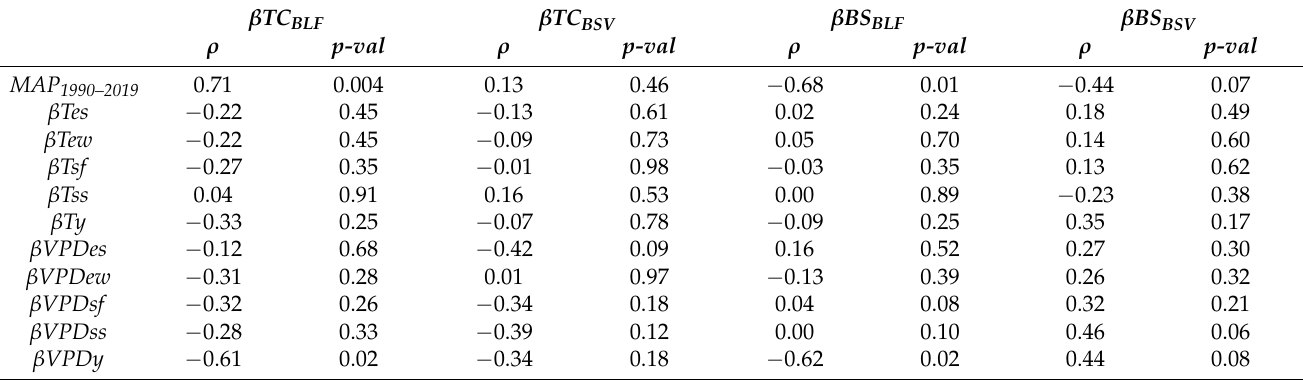
Table 4. Pearson correlation coefficients ( ρ ), and relative p-value between the Theil-Sen slope estimators of the percentage of tree cover and bare soil in broad–leaved ( β TC BLF and β BS BLF ) and in bushy sclerophyllous vegetation ( β TC BSV and β BS BSV ) with some of the main climate